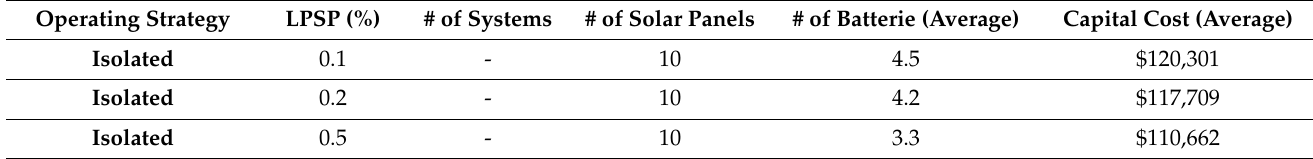
Table A1. Summary table for Indianapolis showing average lowest cost configuration for each case. Operating